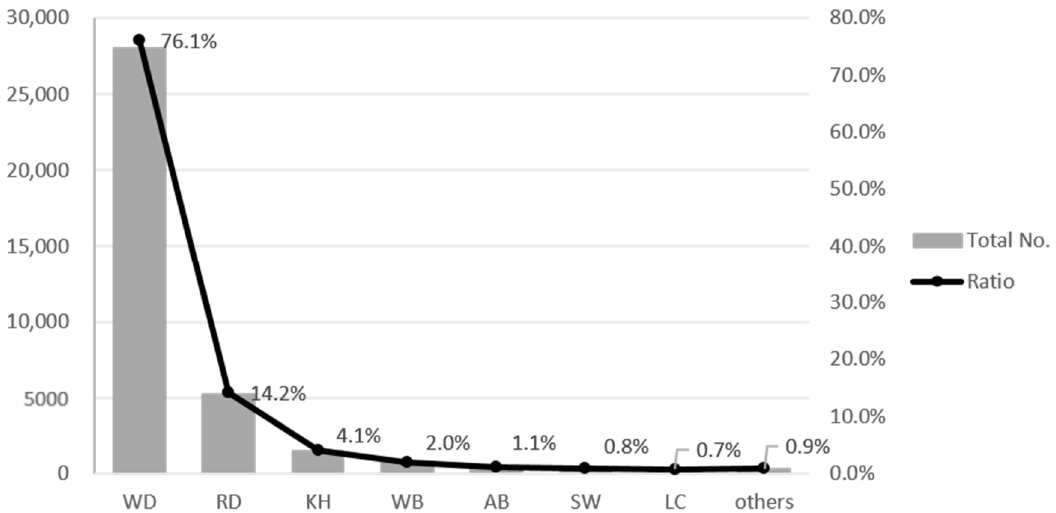
Figure 3. Total number and percentage (%) of roadkills by species on expressways in Korea in 2004–2019. (WD: Water deer, RD: raccoon dog, KH: Korean hare, WB: wild boar, AB: Asian badger, SW: Siberian weasel, LC: Leopard cat).